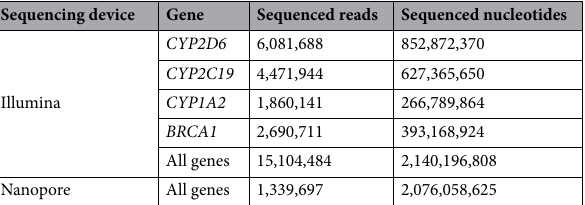
Table 1. Number of sequenced reads and nucleotides from the Illumina and Nanopore sequencing runs.